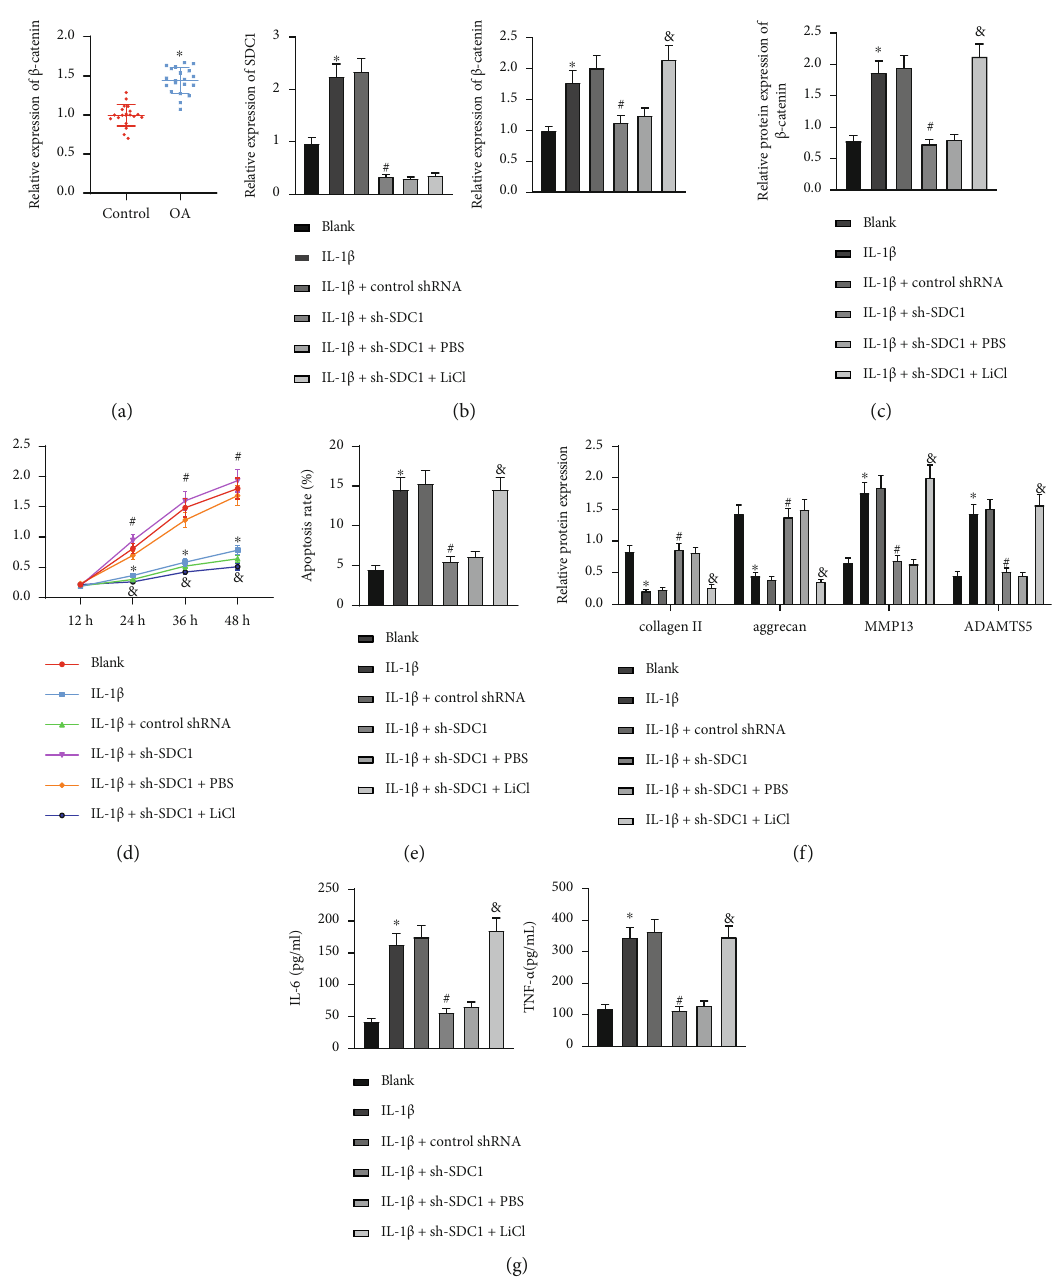
Figure 6: SDC1 induces chondrocyte injury by activating Wnt/ β -catenin pathway. (a) β -catenin mRNA level in the cartilage tissues of OA patients ( n = 20 ) and patients with traumatic amputation ( n = 20 ) determined by RT-qPCR. Chondrocytes were treated with IL-1 β , sh- SDC1, and/or LiCl. (b) mRNA levels of SDC1 and β -catenin in the chondrocytes determined by RT-qPCR. (c) Protein levels of SDC1 and β -catenin in the chondrocytes determined by immunoblotting. (d) Cell proliferation assessed by CCK8 assay. (e) Apoptosis assessed by fl ow cytometry. (f) Protein levels of collagen II, aggrecan, MMP13, and ADAMTS5 in the chondrocytes measured by immunoblotting. (g) Levels of IL-6 and TNF- α in the chondrocytes measured by ELISA. ∗ p < 0 : 05 vs. patients with traumatic amputation or chondrocytes without treatment; # p < 0 : 05 vs. chondrocytes treated with IL-1 β +control shRNA; & p < 0 : 05 vs. chondrocytes treated with IL-1 β +sh-SDC1+PBS. Data are shown as the mean ± standard deviation of three technical replicates. Data between two groups were compared by independent t -test. Data comparisons among multiple groups were analyzed by the one-way ANOVA with Tukey ’ s post hoc test, and comparison of data at di ff erent time points was analyzed using repeated measurement ANOVA with Tukey ’ s post hoc